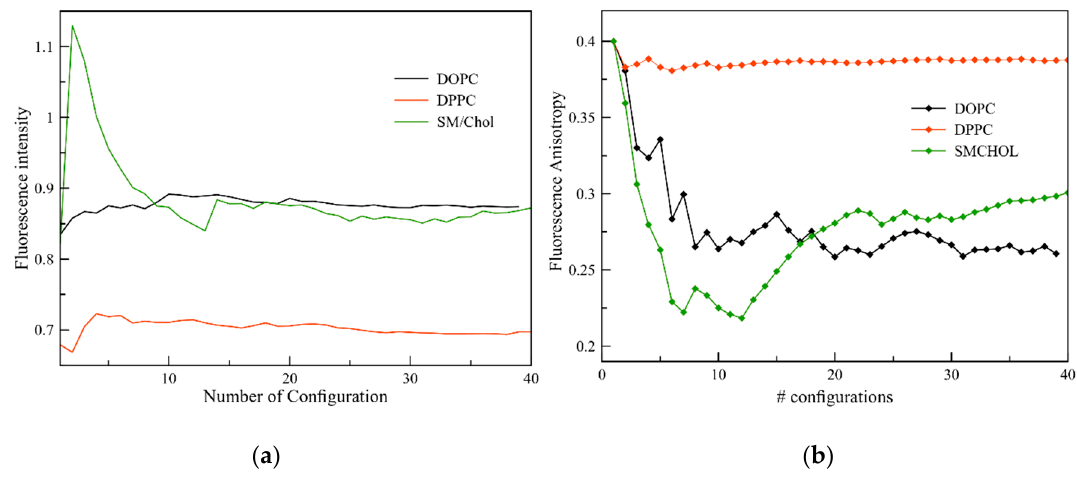
Figure 5. ( a ) Cumulative average of the fluorescence decay time; ( b ) Fluorescence anisotropy